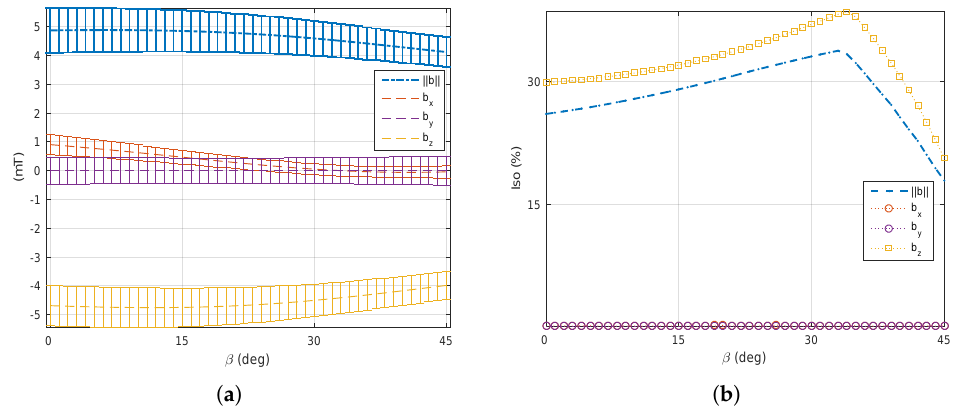
Figure 19. One mobile electromagnet (coil 5) is rotating, and the others are set to β = 33°: ( a ) the average and ( b ) the uniformity of the magnetic